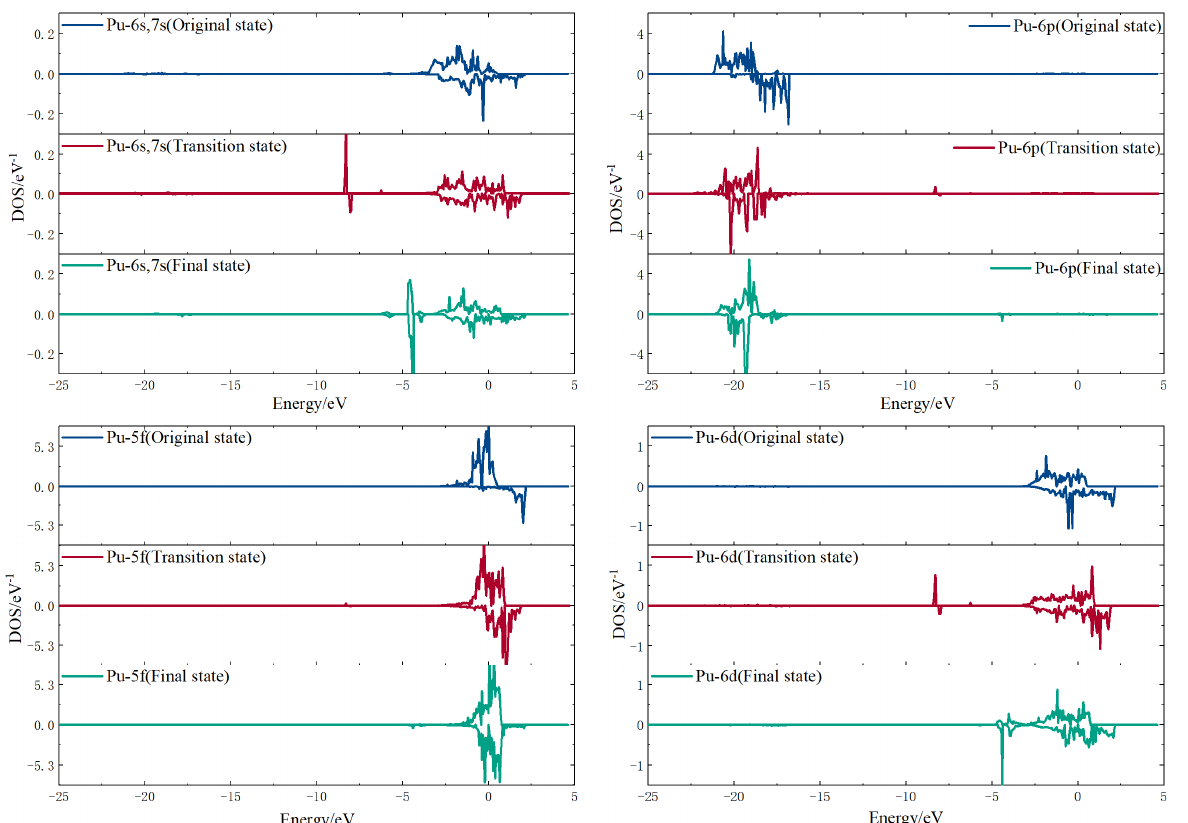
Figure 11. Plutonium Atomic Density of State Variation. Coatings 2022 , 12 , x FOR PEER REVIEW